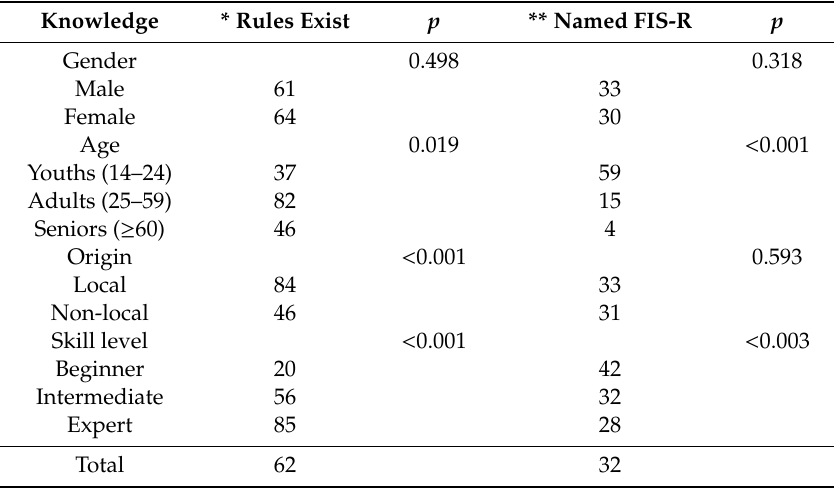
Table 5. General knowledge of International Ski Federation (FIS)